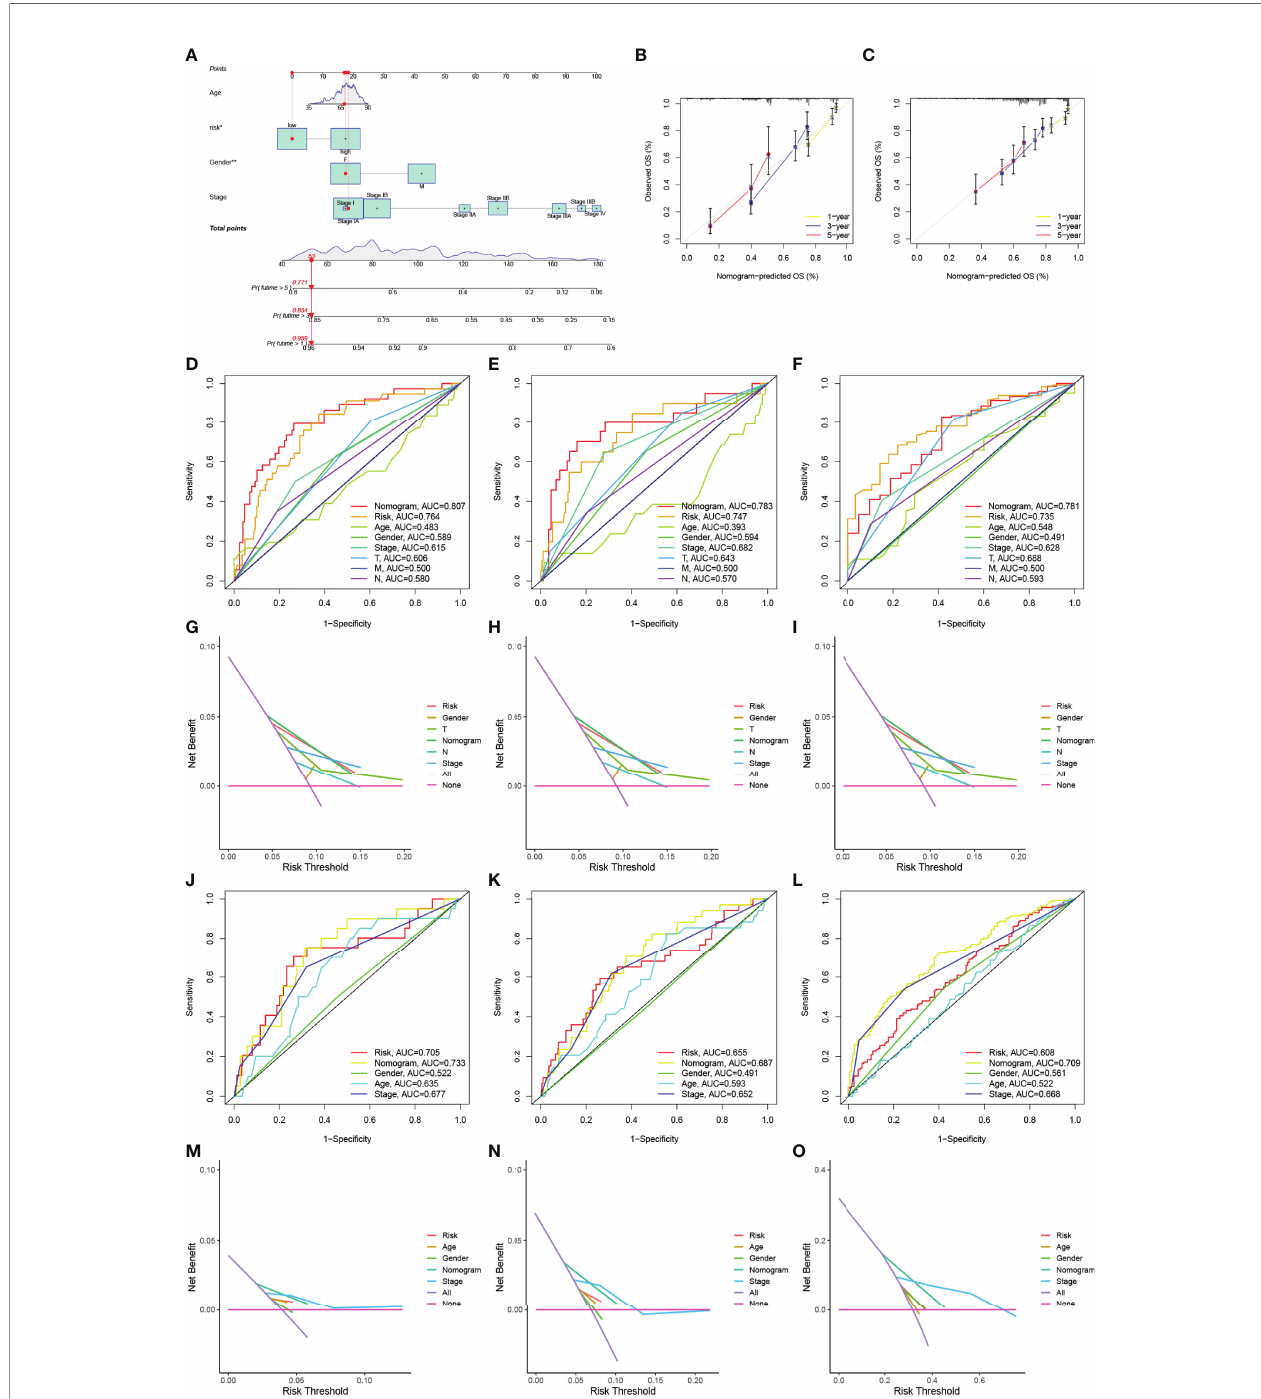
FIGURE 5 | Construction and veri fi cation of the nomogram. (A) The nomogram was constructed using the TNM stage, risk signature, T stage, N stage, and gender. (B, C) Calibration curves verifying the performance of the nomogram at 1, 3, and 5 years in the TCGA-LUAD cohort (B) and GEO datasets (C) . (D – F) ROC curve analysis verifying the performance of the nomogram at 1 (D) , 3 (E) , and 5 years (F) in patients with Stage I LUAD in the TCGA cohort. (D – F) DCA verifying the performance of the nomogram at 1 (G) , 3 (H) , and 5 years (I) in patients with Stage I LUAD in the TCGA cohort; (J – L) ROC curve analysis verifying the performance of the nomogram at 1 (J) , 3 (K) , and 5years (L) in patients with Stage I LUAD in the GEO datasets. (M – O) DCA verifying the performance of the nomogram at 1 (M) , 3 (N) , and 5 years (O) in patients with Stage I LUAD in the GEO datasets. ROC, receiver operating characteristic curve; LUAD, lung adenocarcinoma; DCA, decision curve analysis. * represent P ≤ 0.05, ** represent P ≤ 0.01, *** represent P ≤ 0.001, and **** represent P ≤